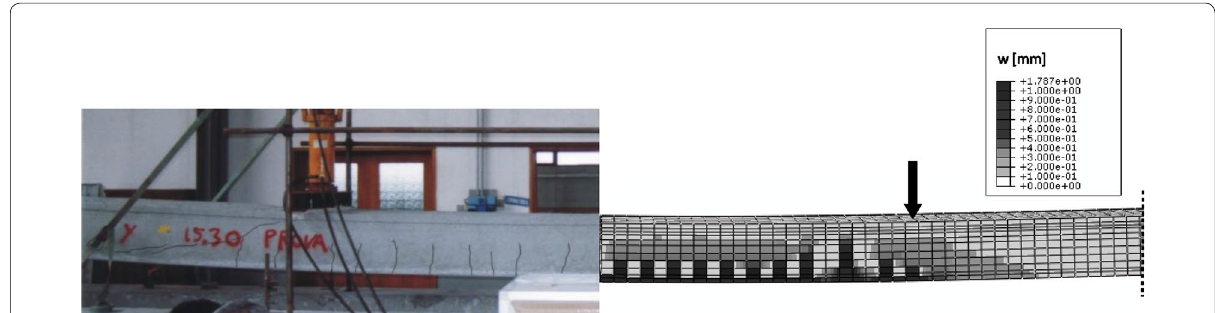
Fig. 14 Flexural tests: comparisons between numerical and experimental crack pattern registered at the end of H50-f1 test (w is the crack opening).